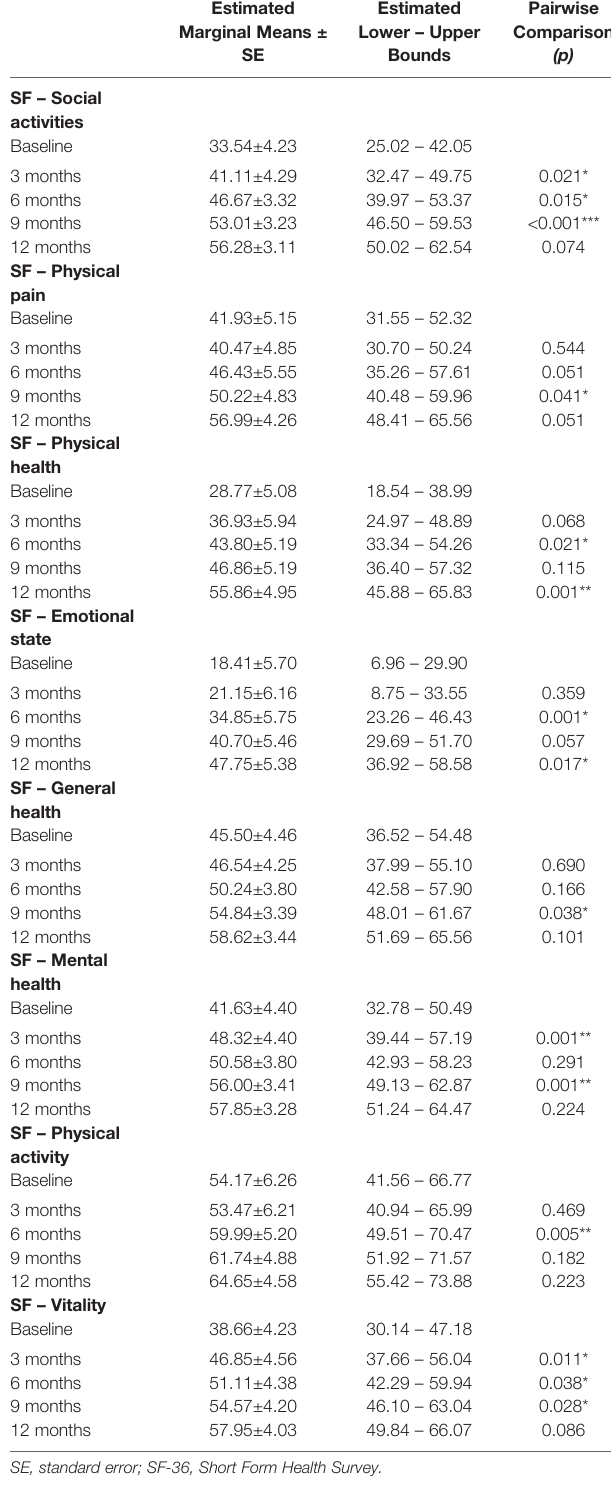
TABLE 4 | SF-36 within-subjects pairwise comparisons; signi fi cance between successive time-points; * p < 0.05; ** p < 0.01; *** p < 0.001. Estimated Estimated Pairwise Estimated Marginal Lower – Upper Comparison Marginal Means Means ± SE Bounds